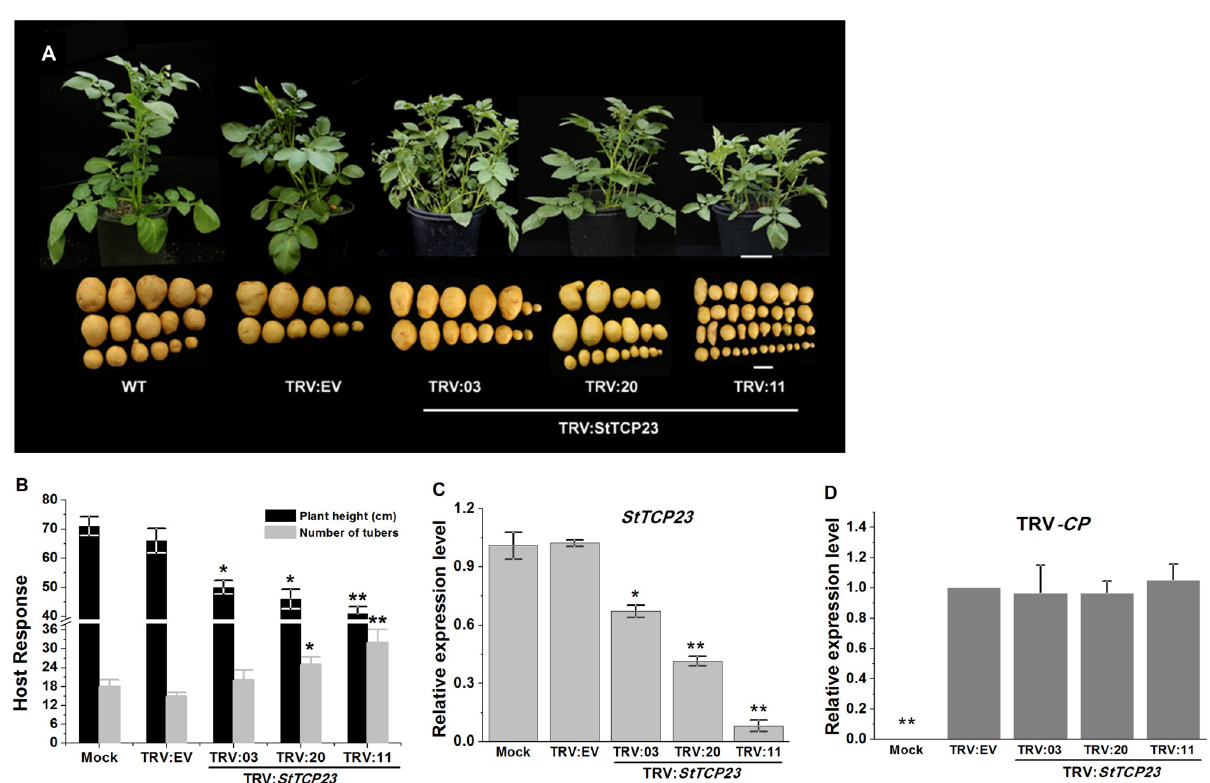
Fig 3. Virus-induced silencing of StTCP23 . (A) Morphology of TRV-infected potato plants in which StTCP23 expression has been suppressed by VIGS. Scale bar = 10 cm (whole plants) or 2 cm (tubers). (B, C) comparison of plant heights and number of tubers (B) and StTCP23 mRNA expression levels (C) in TRV-infected and mock inoculated plants. (D) TRV capsid protein (CP)-coding gene expression levels in StTCP23 -silenced and TRV empty vector-treated potato plants as measured by